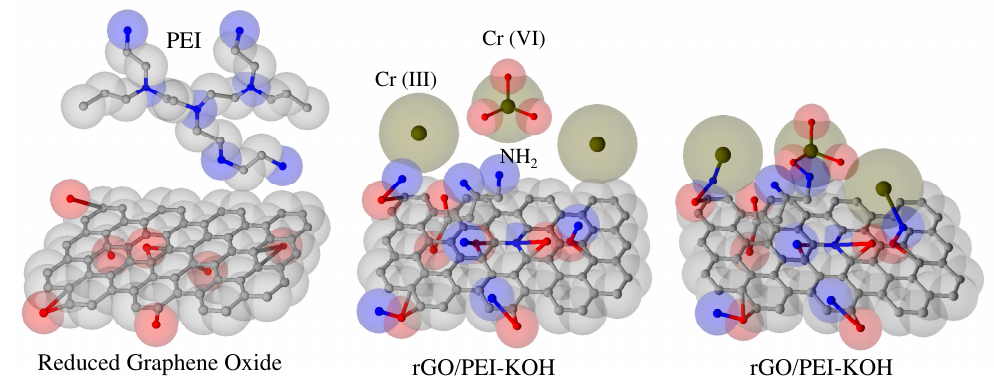
Figure 4. Synthesis of rGO/PEI-KOH and the adsorption process for the selective removal of chromium ions (figure adapted from [97]). The rGO/PEI-KOH synthesis and adsorption pro- cess for selective Cr (VI) removal and chelation between Cr (III) species and deprotonated amino groups ( − NH 2 ).